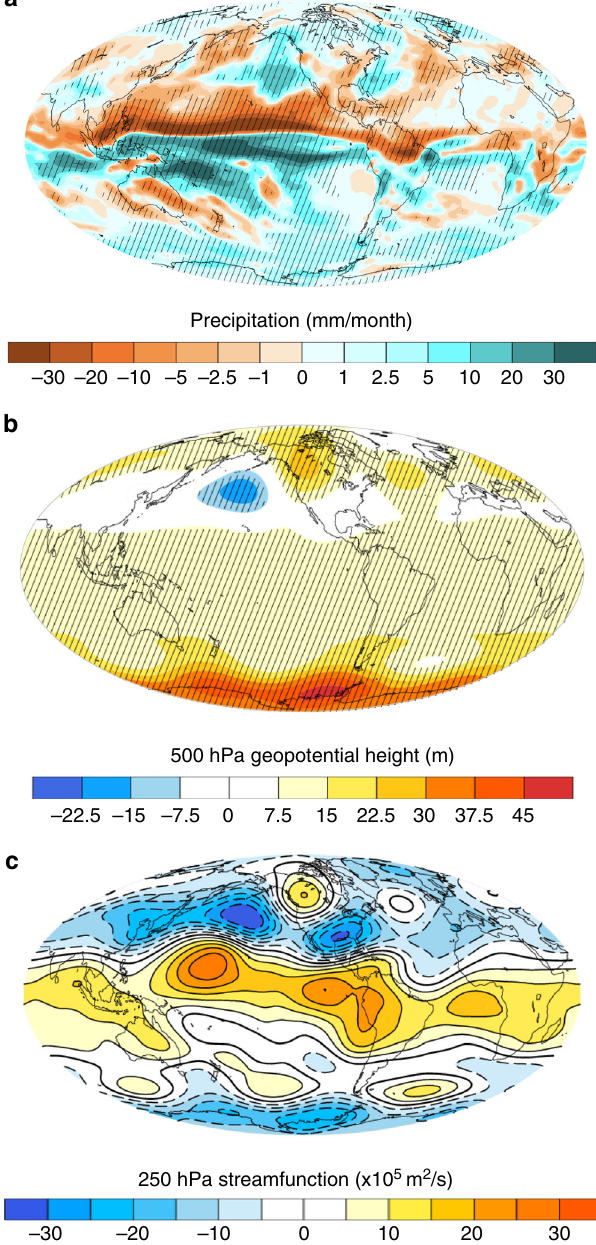
Fig. 5 Atmospheric impacts of Antarctic sea-ice loss. a Precipitation anomalies. b 500 hPa geopotential distribution changes. c Stream function changes. Shown are the ensemble mean differences ( “ low Arctic ice ” minus control) for December – February (DJF) season. Stippling indicates anomalies that are statistically signi fi cant at the 90% con fi dence